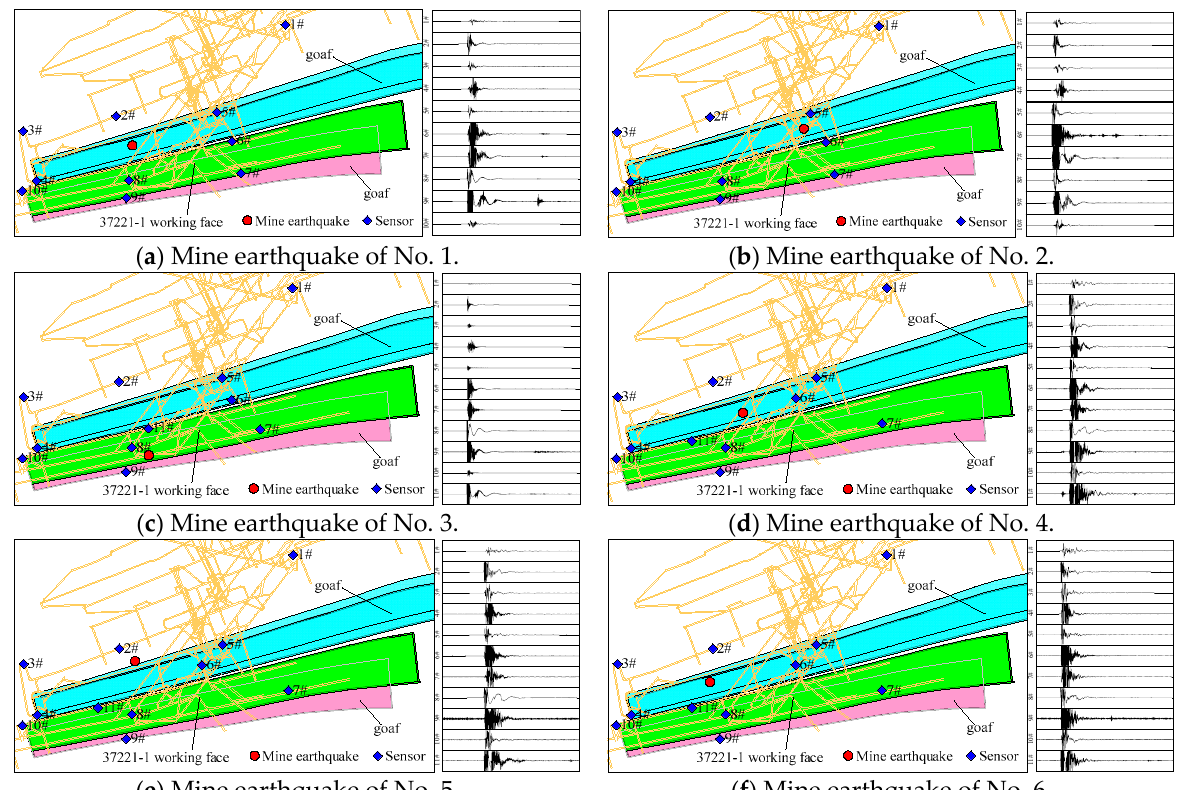
Figure 6. Plan of sensor layout and mine earthquake waveform.